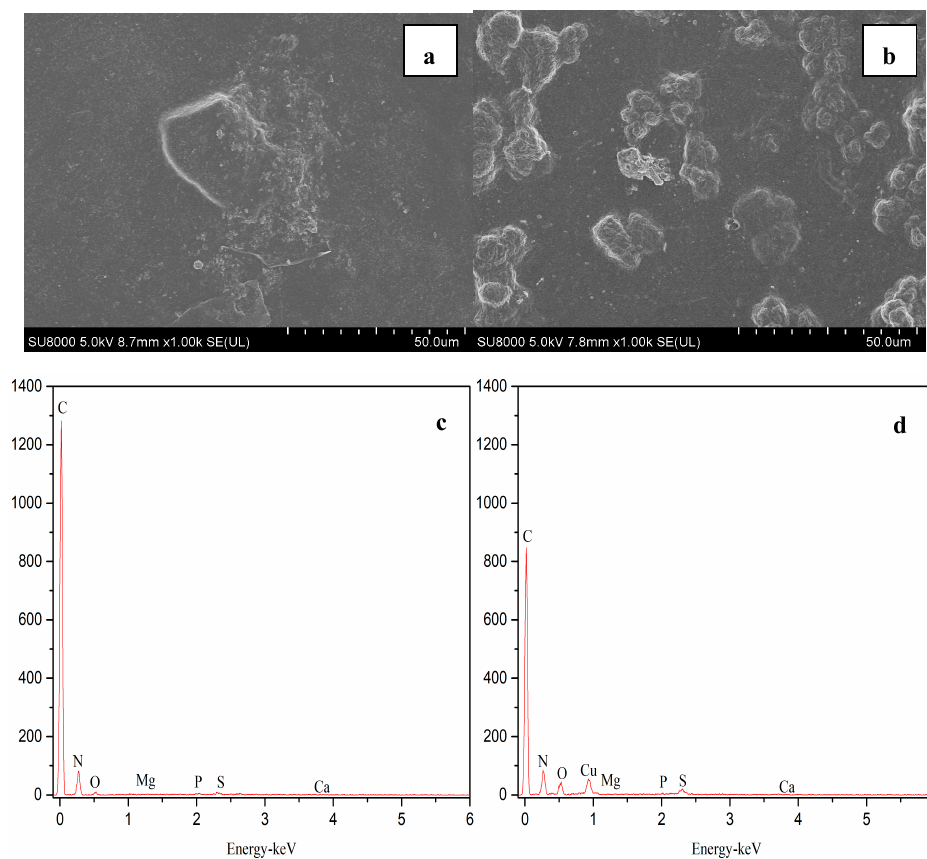
Figure 3. Surface images of the fouled microfiltration (MF) membranes: SEM images and EDX spectrums at different operating modes of constant flux ( a , c ) and varying flux ( b , d ).